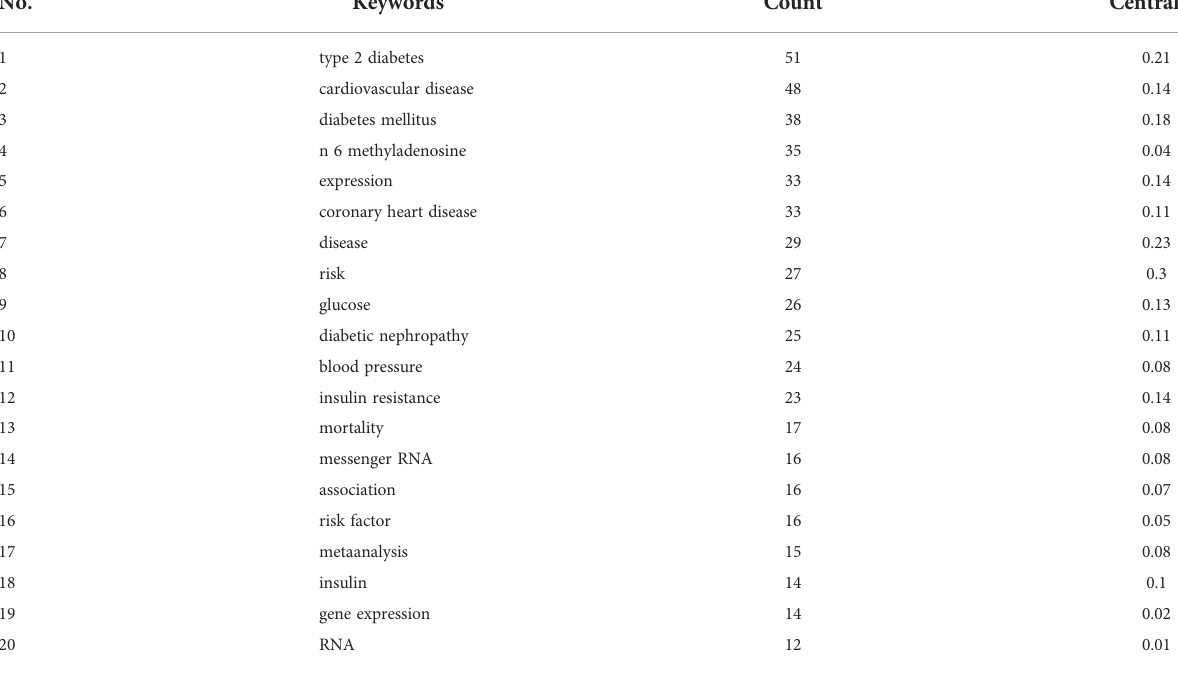
TABLE 3 The top 20 keywords related to RNA methylation in DM and its